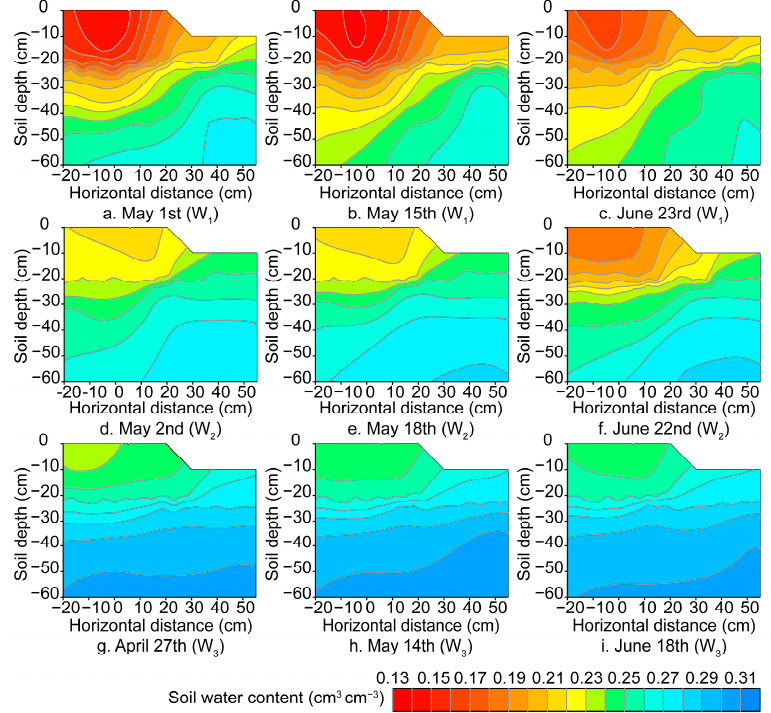
Figure 8. Distribution of soil water content (cm 3 ·cm − 3 ) on the day before three irrigations under different water treatments, in 2020.